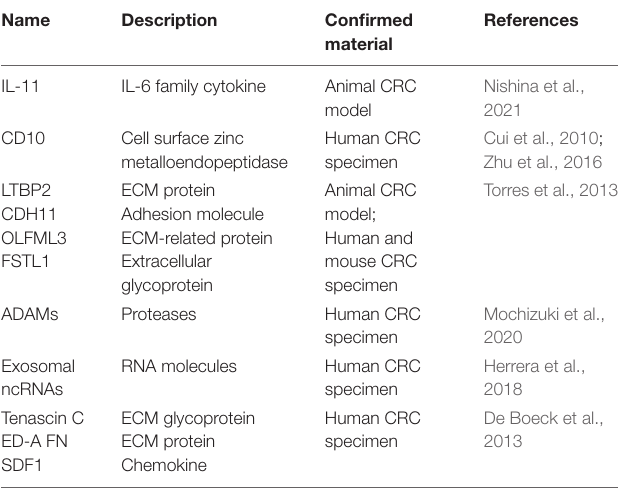
TABLE 2 | Candidate markers of CAFs in